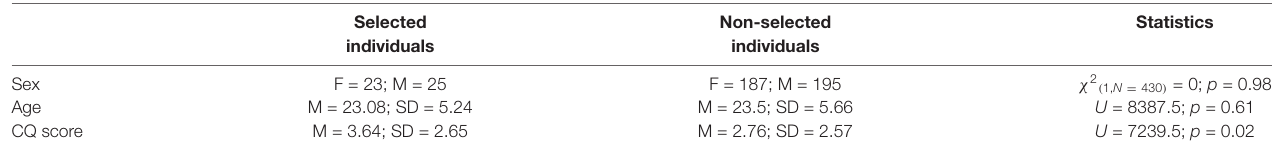
TABLE 1 | Comparison of demographic characteristics and intensity of childhood adversity (CA) between selected and non-selected individuals. Selected Non-selected Statistics individuals